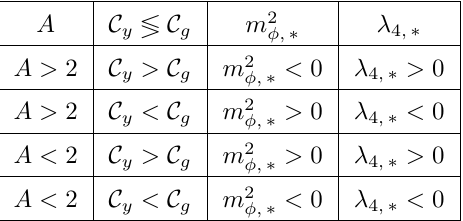
Table 1 . The qualitatively di(cid:11)erent (cid:12)xed-point structure for the mass-term and quartic coupling (cid:21) 4 of the scalar potential depends on gravitational ( A > 2), gauge ( C g ) and Yukawa ( C y ) contributions at the UV (cid:12)xed